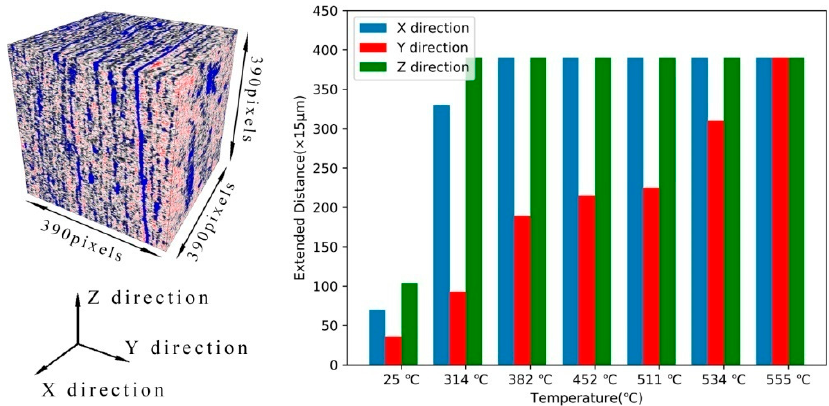
Figure 10. Extension length of the largest pore-fracture cluster in the x, y, and z directions at different pyrolysis temperatures.